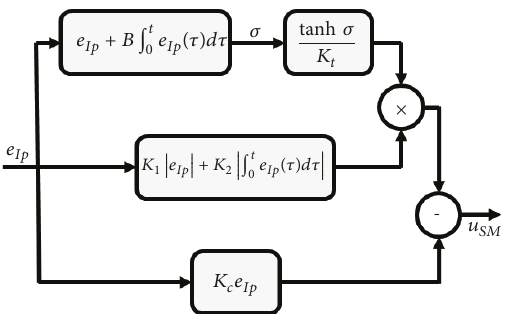
Figure 6: Sliding mode